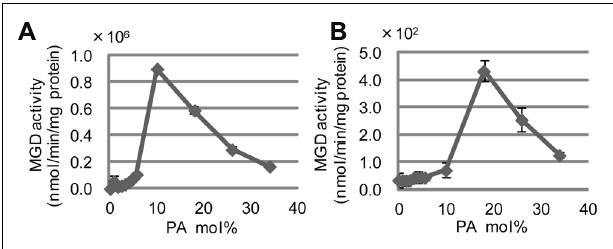
FIGURE 6 | Induction of Se MGD activity by phosphatidic acid (PA). (A) Se MGD1. (B) Se MGD2.Values represent the mean ± SD from three independent